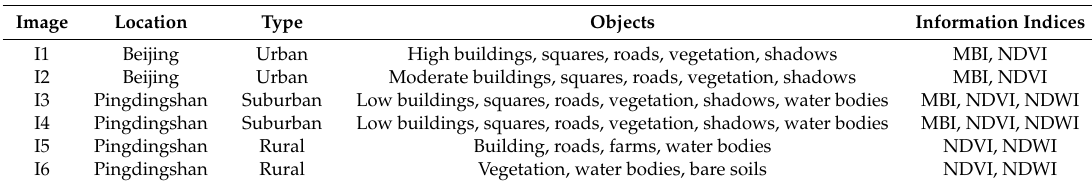
Figure 2. The selected six dataset used in the experiments. ( a ) I1; ( b ) I2; ( c ) I3; ( d ) I4; ( e ) I5; ( f ) I6. Table 1. The description of the selected six datasets.